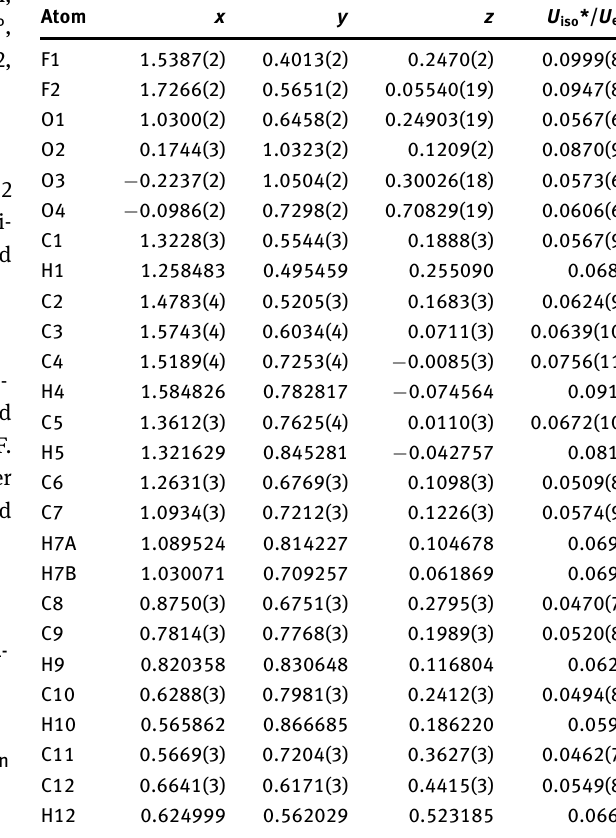
Table 2: Fractional atomic coordinates and isotropic or